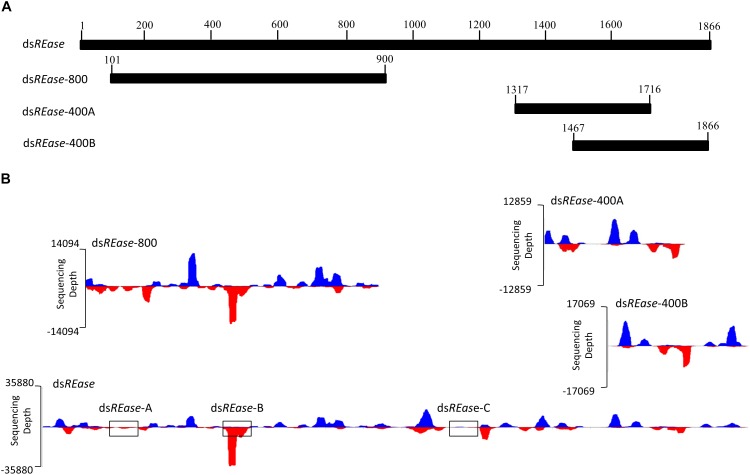
The dsRNA-processing model is closely related to its nucleotide sequence. (A)
REase gene expression levels under different treatments. Fifth instar Asian corn borer larvae were independently injected with 10 μg of dsREase, dsREase-800, dsREase-400A, and dsREase-400B. Four hours later, samples were collected and REase gene expression levels were determined by qRT-PCR. Compared to the dsEGFP treatment, the REase gene can be repressed by the four kinds of dsREase. (B) Processing mode of the four kinds of dsREase
in vivo. Fifth instar Asian corn borer larvae were independently injected with 10 μg of dsREase, dsREase-800, dsREase-400A, and dsREase-400B. Four hours later, RNAs were isolated for small RNA sequencing. Small RNAs of 19–25 nt long were re-mapped on the reference sequences (x-axis) to produce the graph. Blue peaks indicate that the small RNAs matched on the sense chain. Red peaks indicate that the small RNAs matched on the anti-sense chain. The x-axis represents the REase sequence, and the y-axis represents the depth of sequencing (amount of mapped small RNA). The three black boxes of dsREase-A, dsREase-B, and dsREase-C were 100 bp sequences in different position for small RNAs analysis. For the statistical results, please see Supplementary Figure 3.